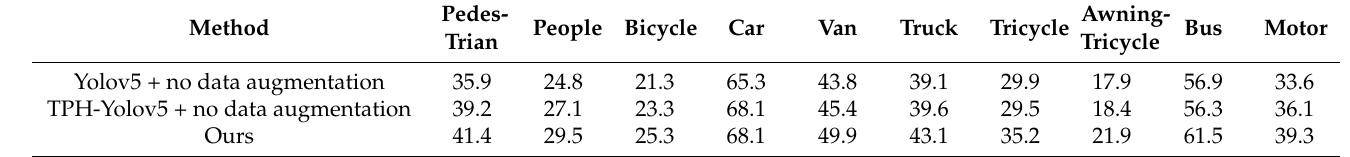
Table 3. Detection performance of each object category on the Visdrone2019 validation set.